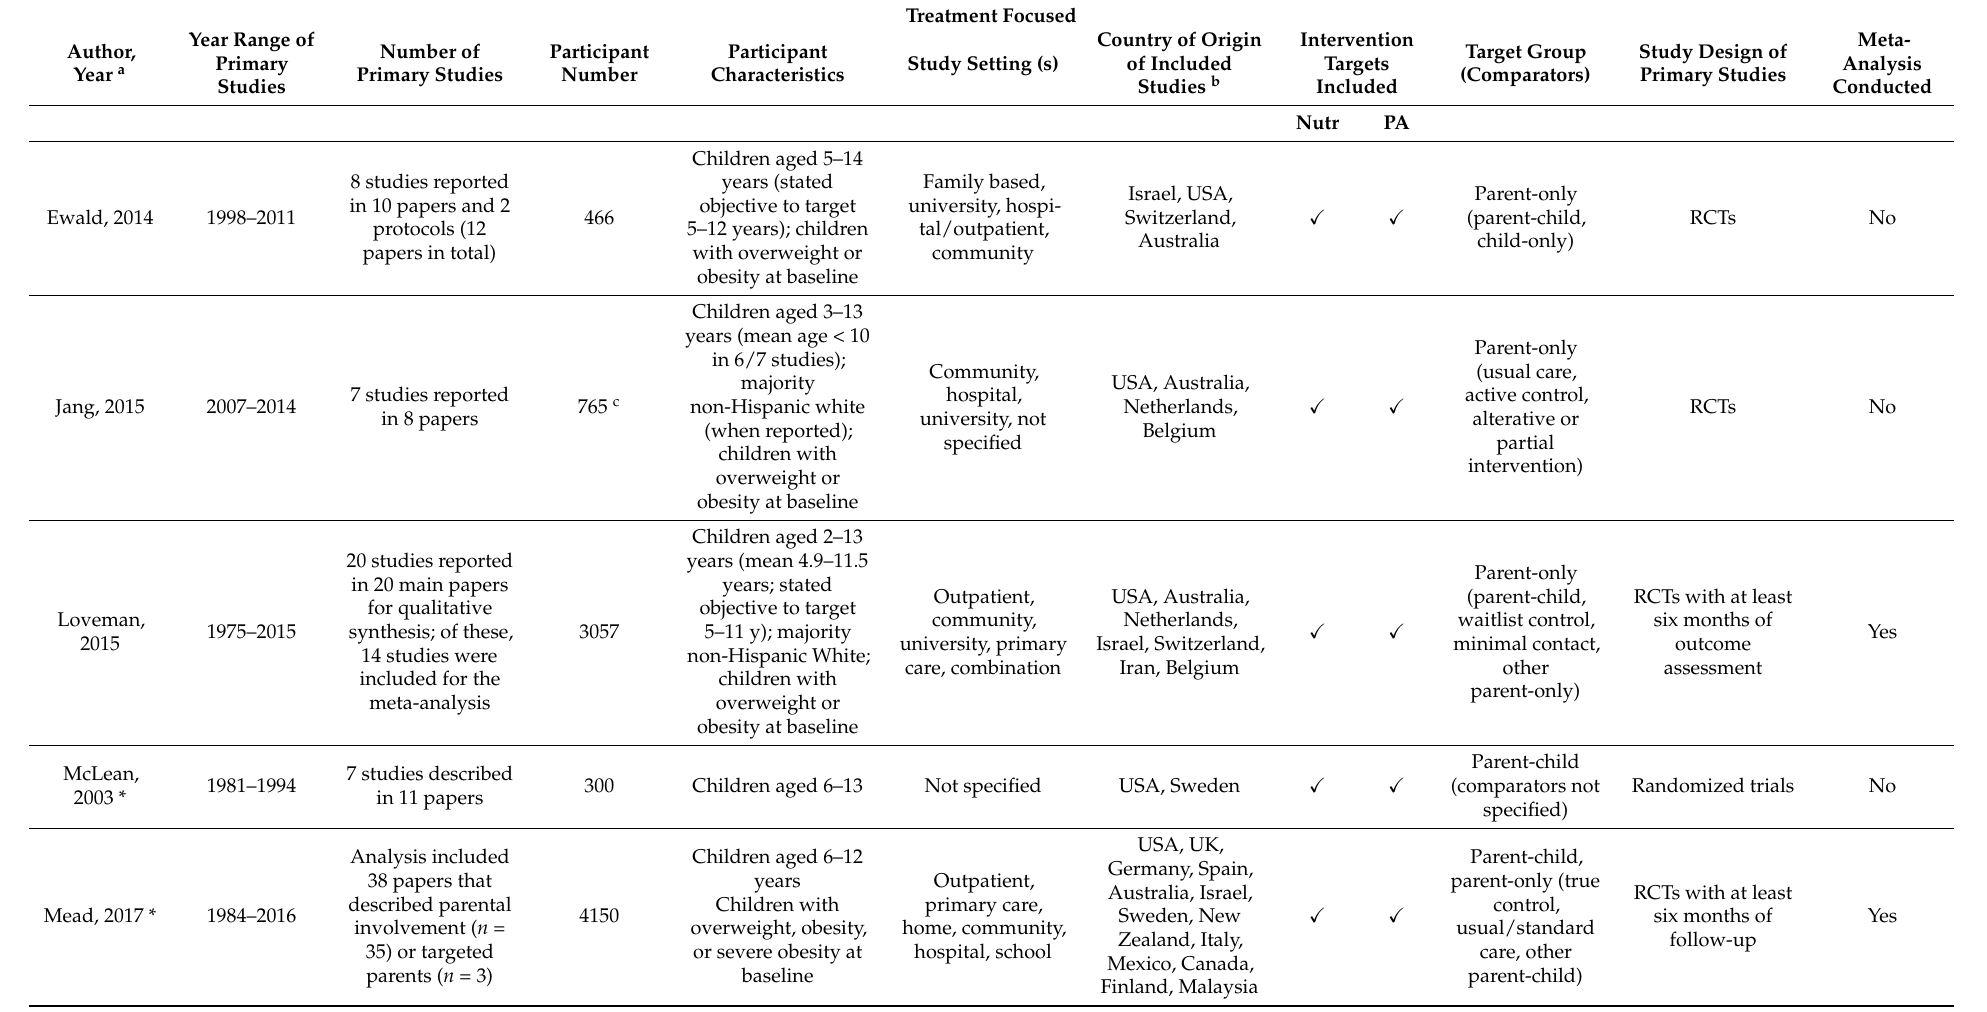
Table 1. Characteristics of Included Meta-Analysis and Systematic Reviews by Intervention Focus (Treatment and